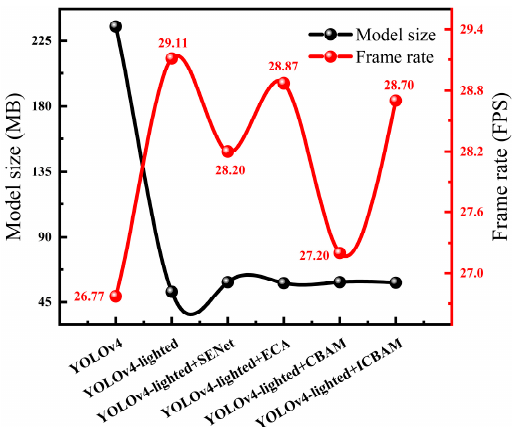
Figure 9. Comparison curve of size and frame rate of different recognition models.